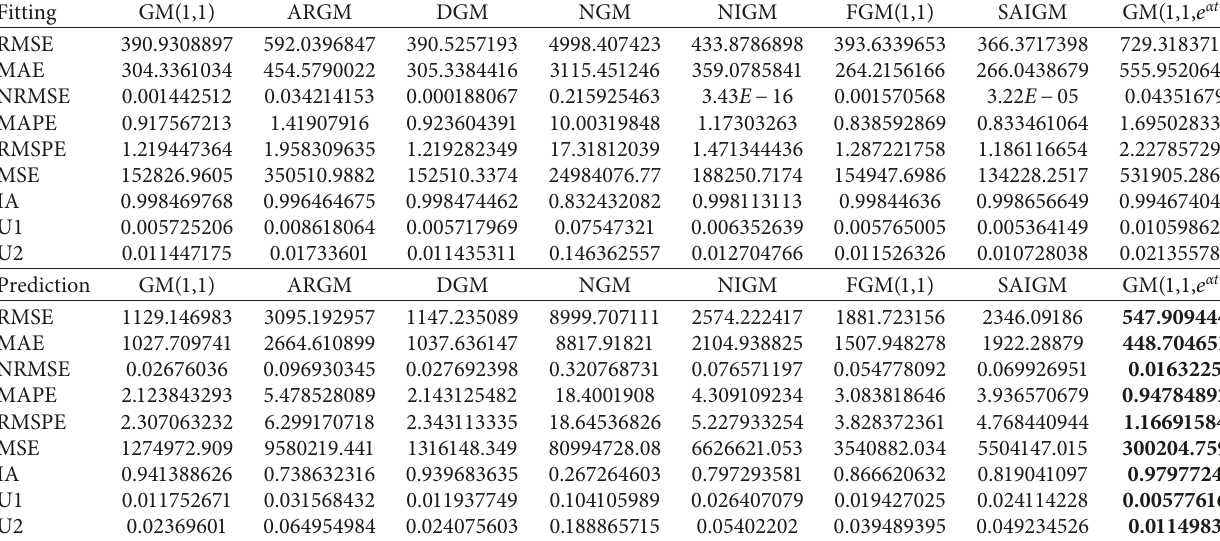
Table 12: Evaluation result of different grey models for fitting and forecasting China’s total residential energy consumption in Case 1.